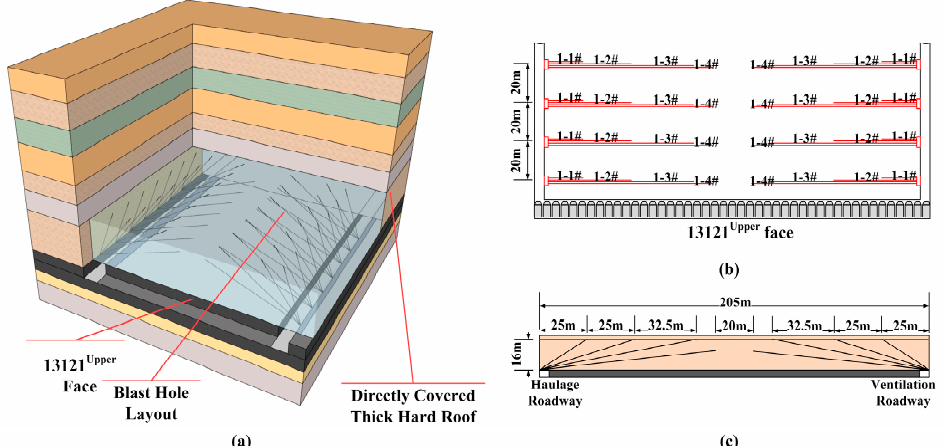
Figure 9. Schematic diagram of top cutting of a directly covered thick hard roof: ( a ) Schematic diagram of the overall effect of top cutting; ( b ) The top view effect diagram of the working face top cutting scheme; ( c ) A schematic cross-sectional view of the top cutting scheme.